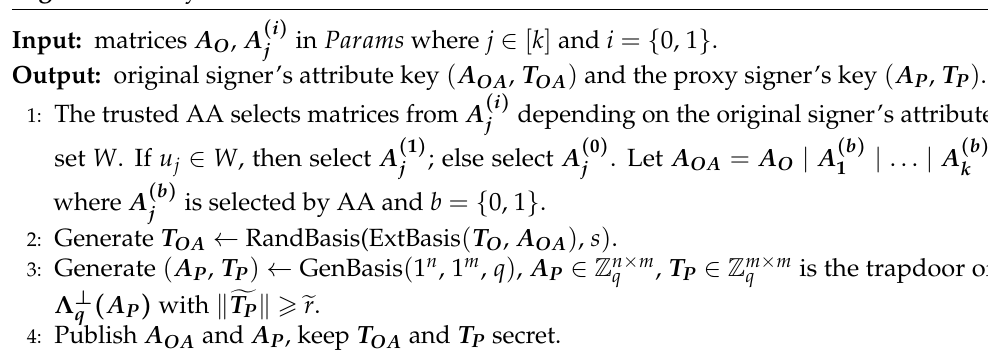
Algorithm 2 Key